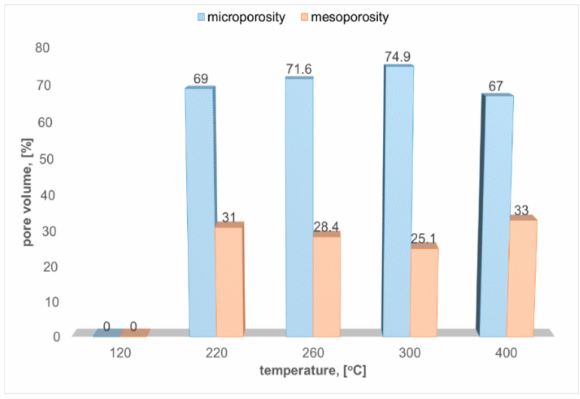
Figure 2. Microporosity / mesoporosity evolution with firing temperature.